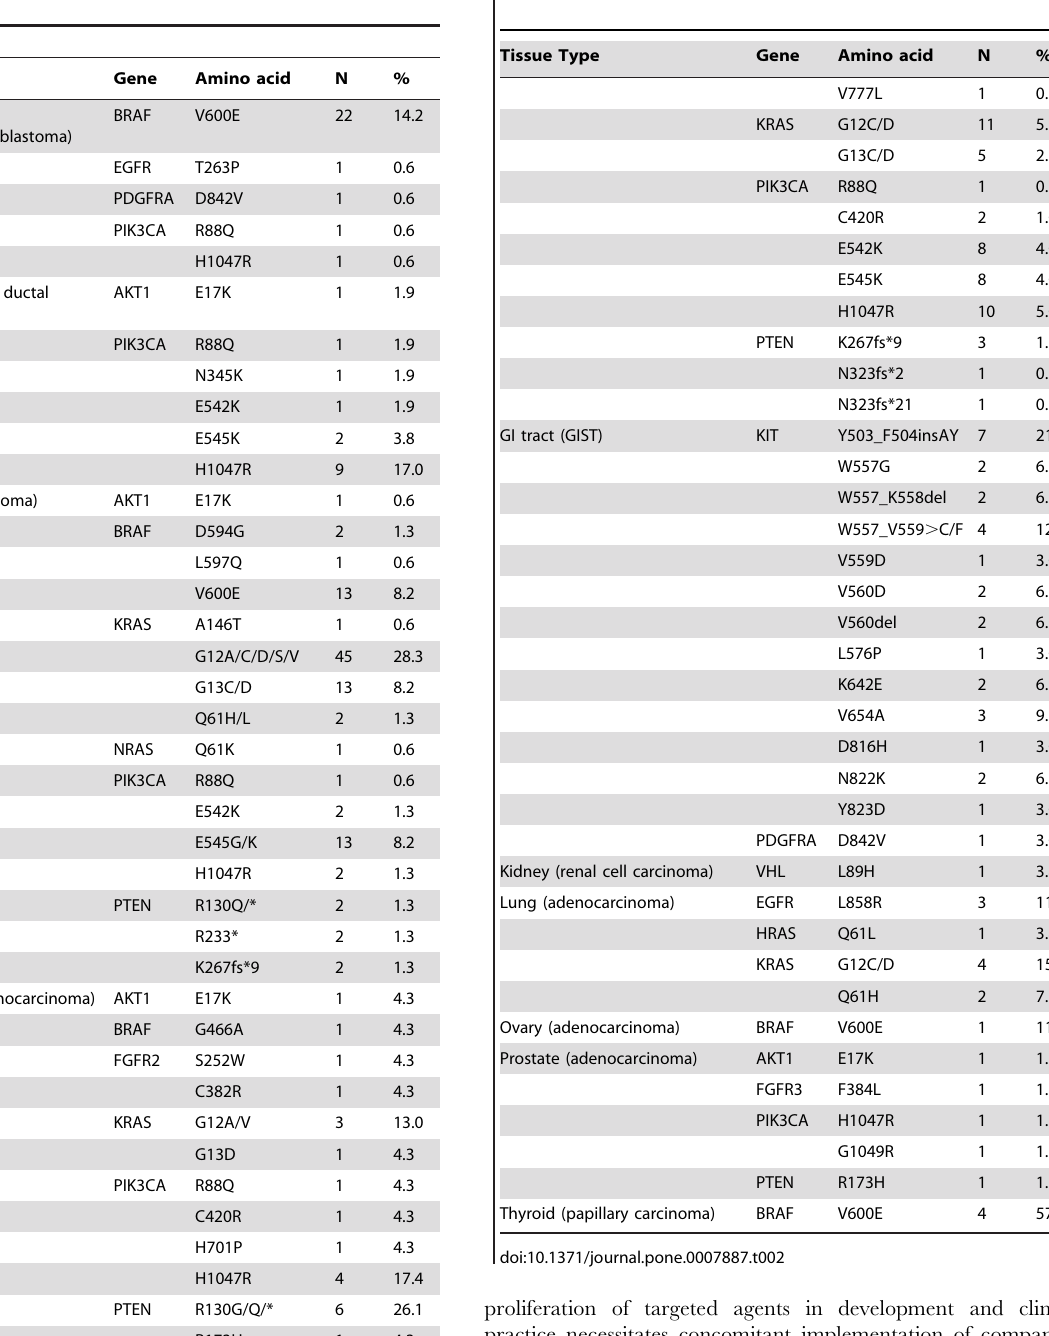
Table 2. Druggable or actionable mutations identified in this